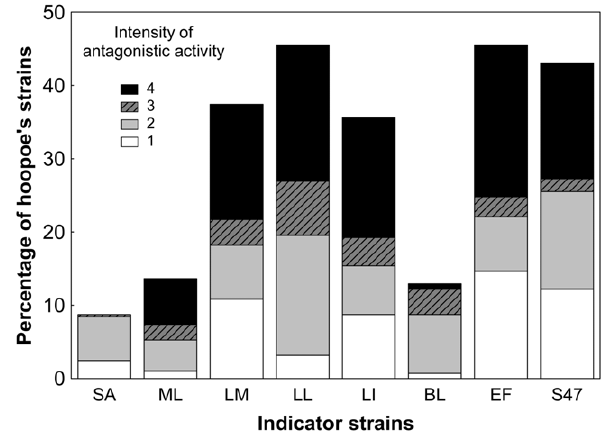
Figure 2. Intensity of antimicrobial activity. Variation in the inhibitory intensity against each indicator strain by symbiotic bacteria isolated from the uropygial gland secretion of hoopoes. (SA: S. aureus ; ML: M. luteus ; LM: L. monocytogenes ; LL: L. lactis ; LI: L. innocua ; BL: B. licheniformis ; EF: E. faecium ; S47: E. faecalis ). Intensity of antagonistic activity: 0 (no halo), 1 (ring width , 1 mm), 2 (ring width=1–2 mm), 3 (ring width=3–4 mm), and 4 (ring width . 4 mm.).